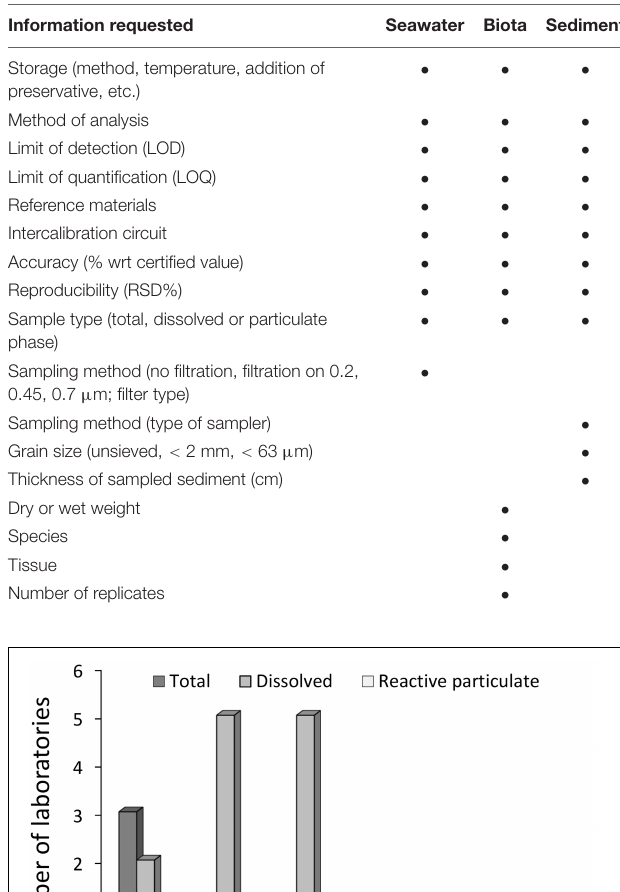
TABLE 2 | Information requested for each matrix.